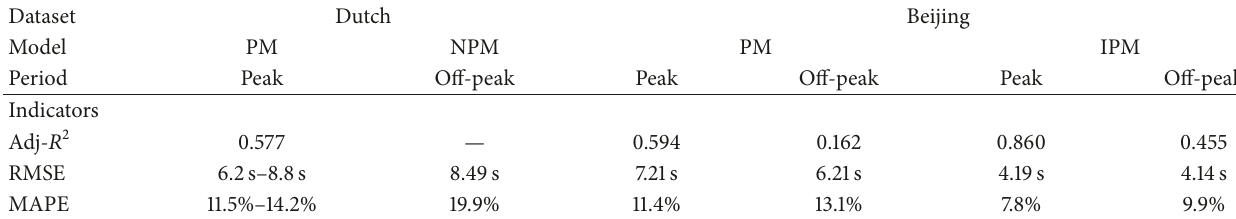
Table 13: Comparison with the improved parametric